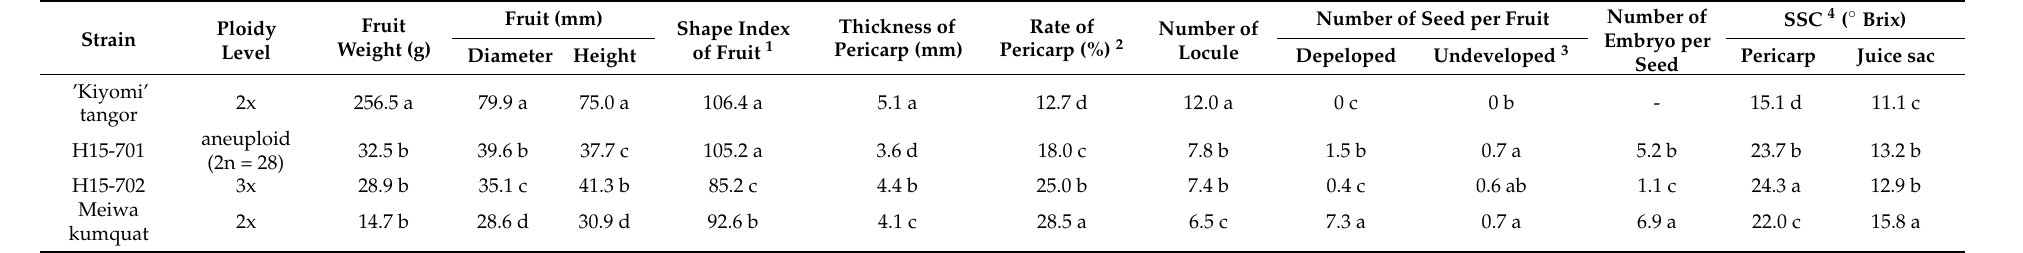
Table 5. Morphological characteristics of fruit in ‘Kiyomi’ tangor, Meiwa kumquat, and their hybrids. Different letters represent significant differences in Tukey’s multiple range test, 1% level (number of embryos = 50, others =